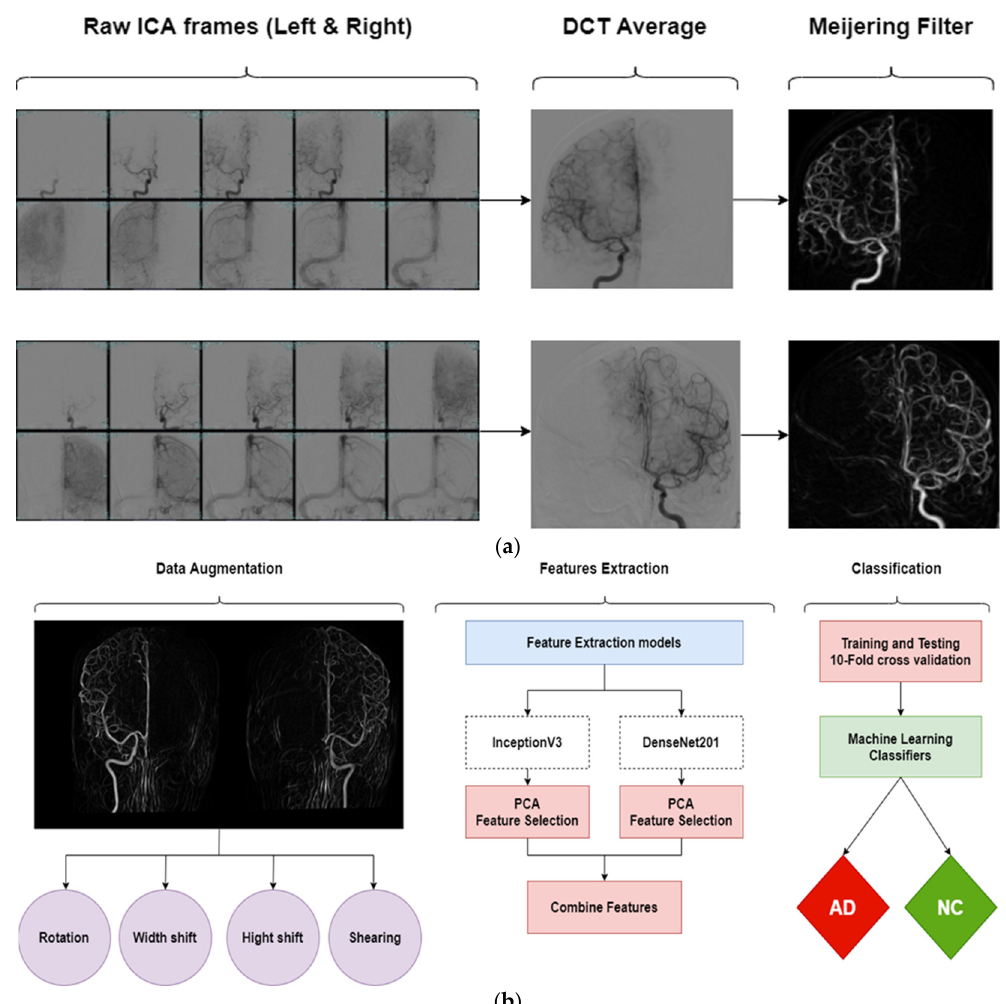
Figure 1. The workflow of the proposed methodology: ( a ) preprocessing steps after data acquisition, ( b ) data augmentation, features extraction, and classification.